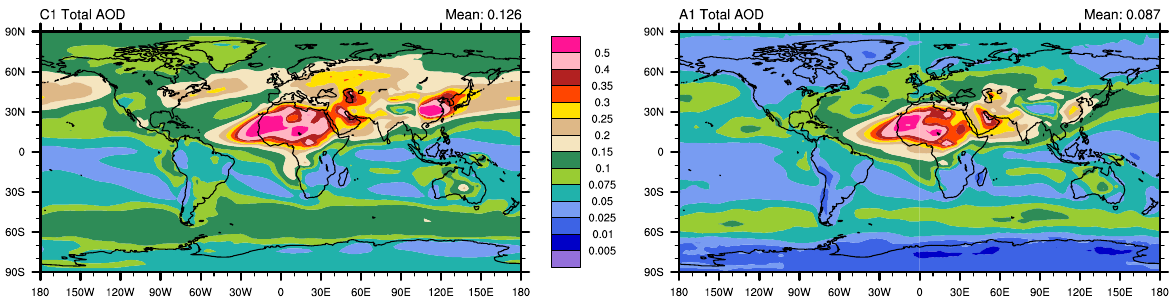
Fig. 10. Total aerosol optical depth from C1 (left) and A1 (right).